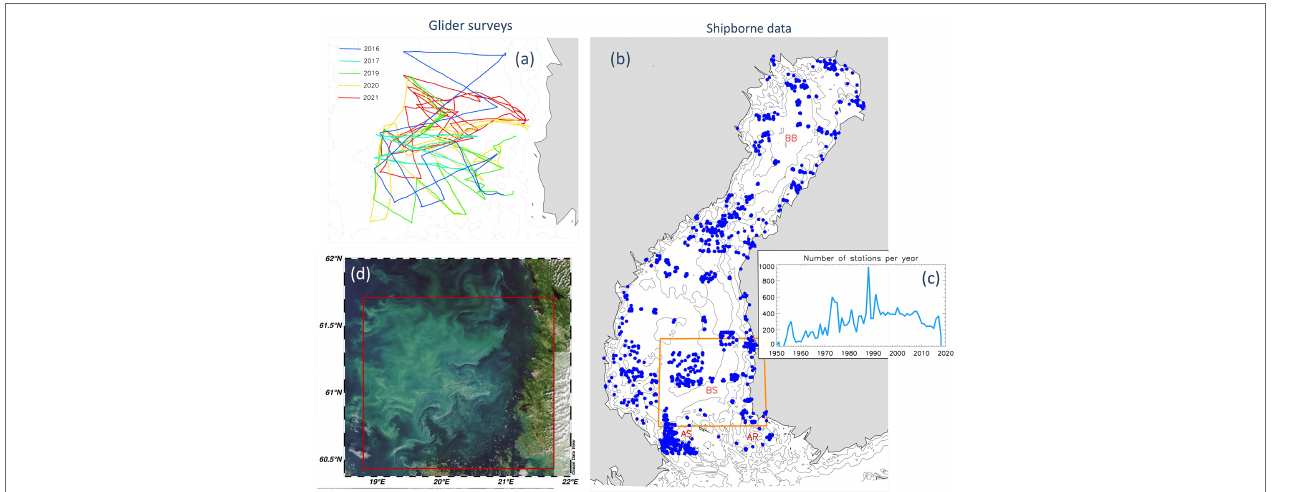
FIGURE 1 | (A) Glider and (B, C) shipborne data used in this study and (D) summer bloom in the Bothnian Sea captured by satellite observations on August 7, 2020. (A) Glider survey trajectories in 2016, 2017, 2019, 2020 (two surveys), and 2021 (three surveys). (B, C) Spatiotemporal data coverage used to develop climatology of the Gulf of Bothnia. Orange box in (B) indicates the area with glider observations. The Bothnian Bay (BB), Bothnian Sea (BS), Åland Sea (AS) and Archipelago Sea (AR) are indicated in (B) . (D) True color satellite image made on August 7 th , 2020 from TARKKA service of Finnish Environment Institute (SYKE) containing modified Copernicus data (SYKE 2020). Red box indicates the area with glider